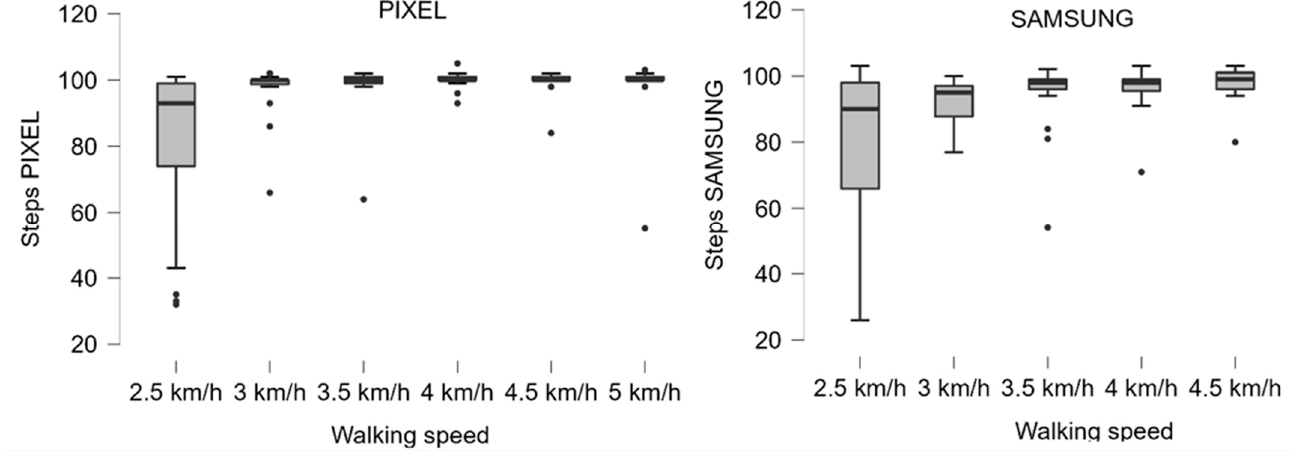
Figure 1. Box plot of the number of steps for both devices at the six different speeds. Median and interquartile range are demonstrated.